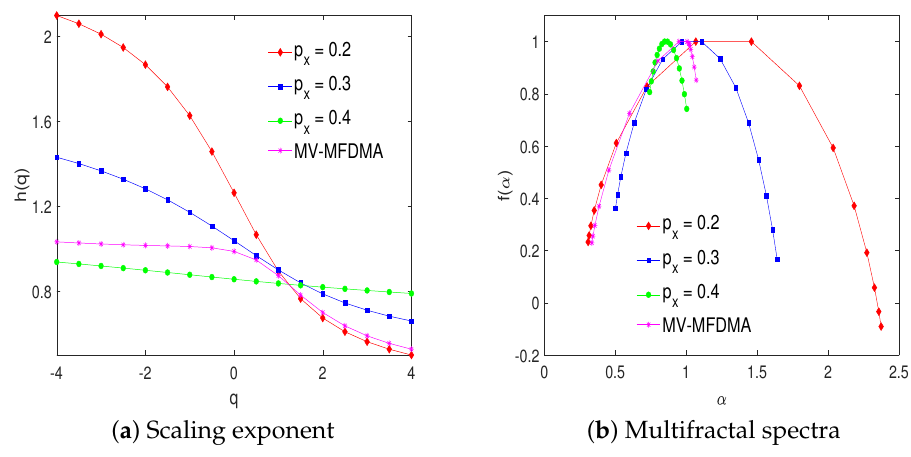
Figure 4. Multifractal